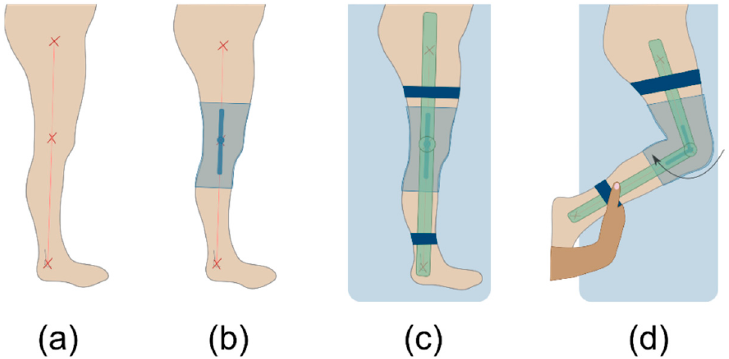
Figure 2. The four main steps of the calibration process; ( a ) marking and connecting anatomic landmarks, ( b ) putting on the instrumented knee brace, ( c ) attachment and alignment of the additional calibration goniometer in prone position, ( d ) passive knee movement in prone position by the investigator.